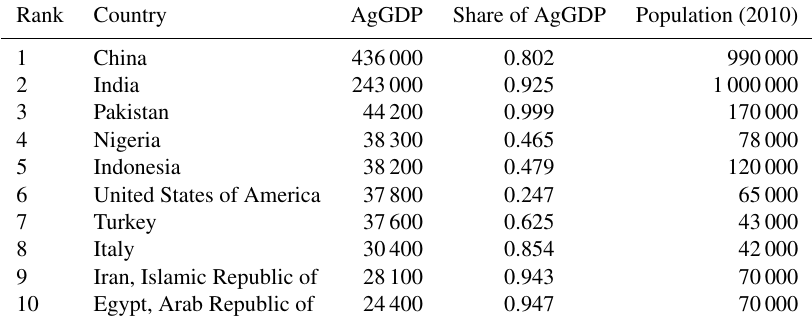
Table B4. Top 10 countries with the largest total agricultural GDP exposed to WCI areas with agricultural GDP (millions of USD) and population (thousands).